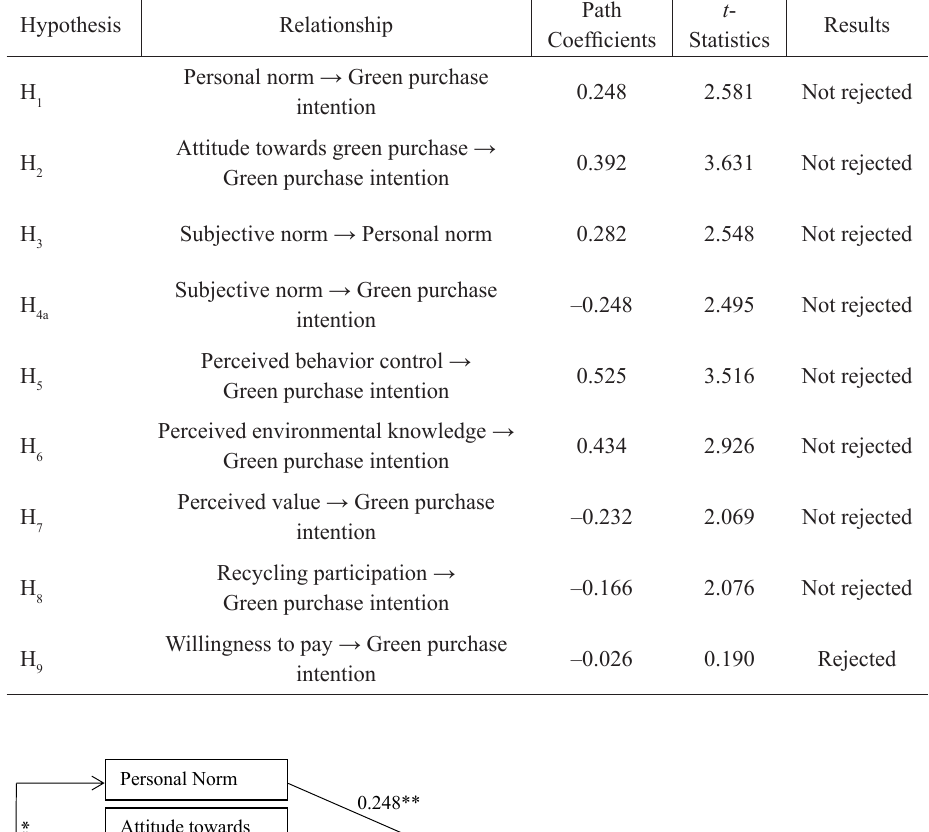
Table 6. Findings of hypotheses investigation